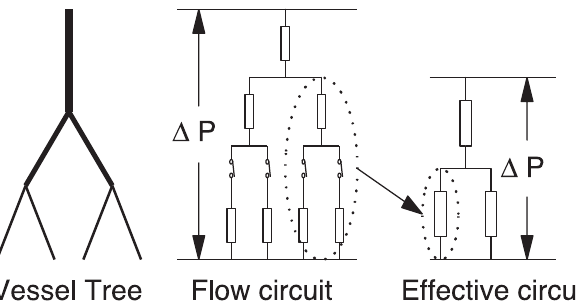
Figure 6. A vessel tree, its flow circuit and its effective circuit. In the simulation, in order to compute blood flows in all the vessels, small vessel crowns are replaced by their corresponding effective resistances.